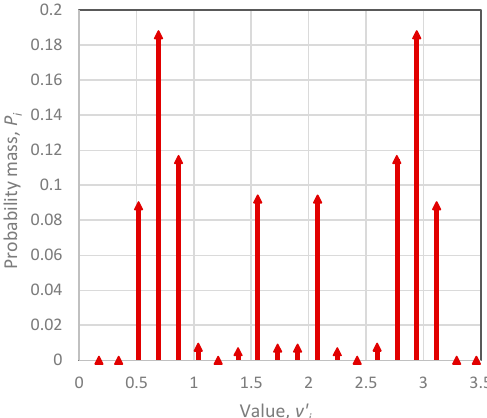
Figure 2. Probability mass function of the discretized white noise used in the simulation application for a synthetic example of a persistent FHK process with uniform distribution.